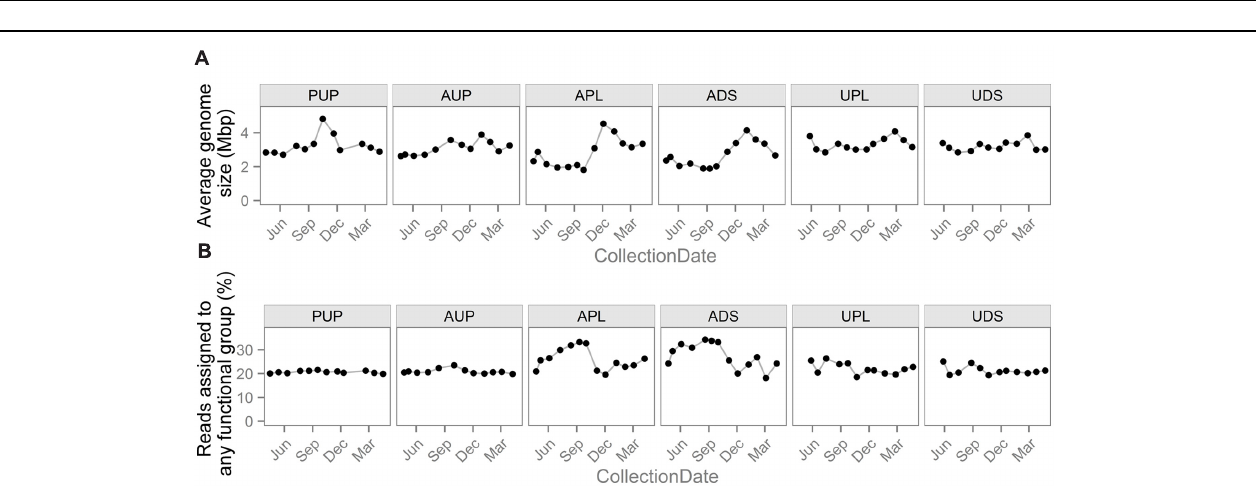
FIGURE 3 | Average genome size (AGS) across sampling sites, colored by daylight hours, illustrating correlations within the agricultural watershed. Points represent samples and are jittered on the x -axis for visibility. The agriculturally affected sites (APL, ADS) have the largest ranges of values. There is a significant negative correlation between AGS and daylight hours in all sites in the agricultural watershed and a corresponding trend in PUP.